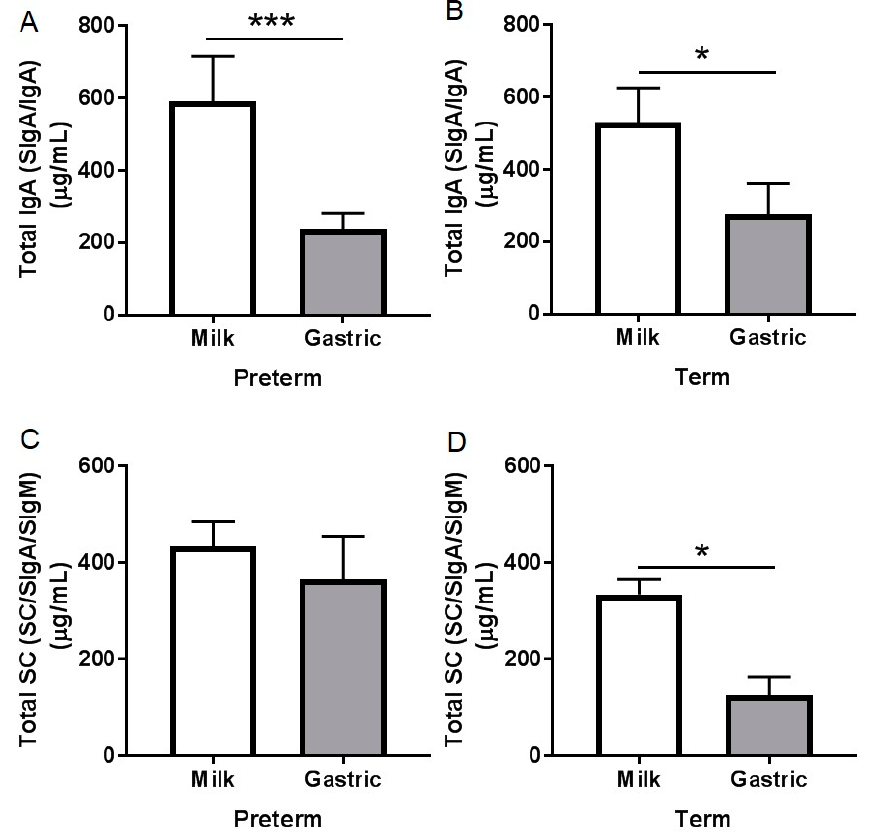
Figure 1. Immunoglobulin concentrations in human milk and gastric samples at 2 h postprandial